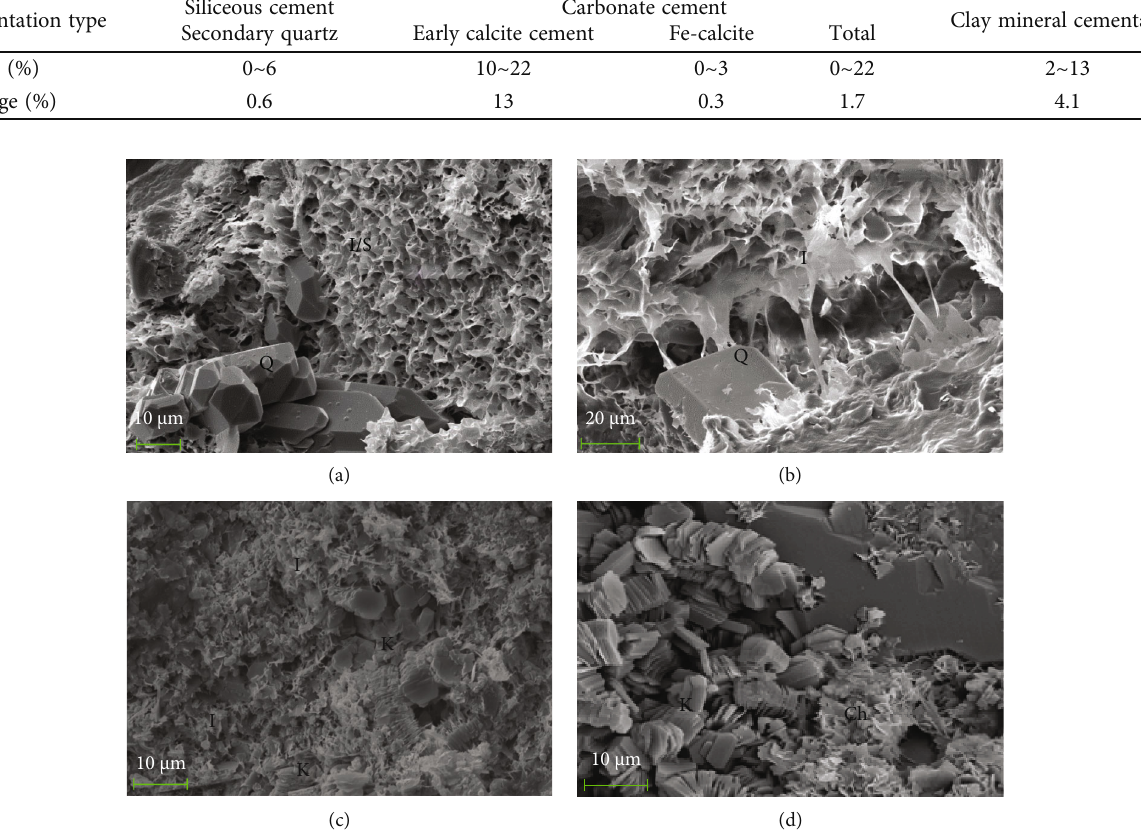
Figure 11: SEM images of the clay minerals of E w in the Southern Lufeng depression. (a) The illite/smectite mixed clay minerals with a 2 honeycomb shape attached to the surface of particles, 4155.25m, W4. (b) The illite takes on the silk-tread form, bridging the pore, 4167.74m, W4. (c) Silk-tread illite and kaolinite symbiotically block fi ll intergranular pores, showing that the illite is transformed from the kaolinite, 3092.3m, W9. (d) Book-like kaolinite fi lls the intergranular pores, 3897m, W2. I/S: illite/smectite; Q: quartz; I: illite; K: kaolinite; Ch: chlorite.